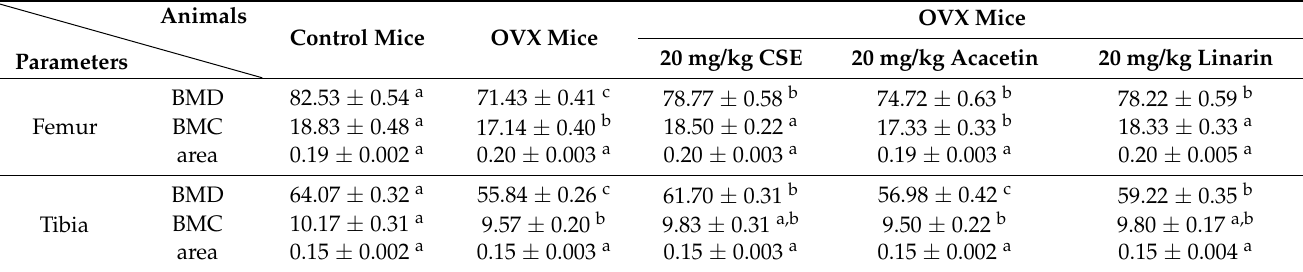
Table 1. Osteogenic activity of CSEs, acacetin, and linarin in OVX mice.